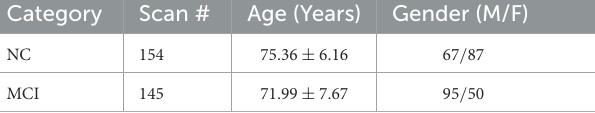
TABLE 1 Demographic information of the studied 299 rs -fMRI scans from the ADNI database.